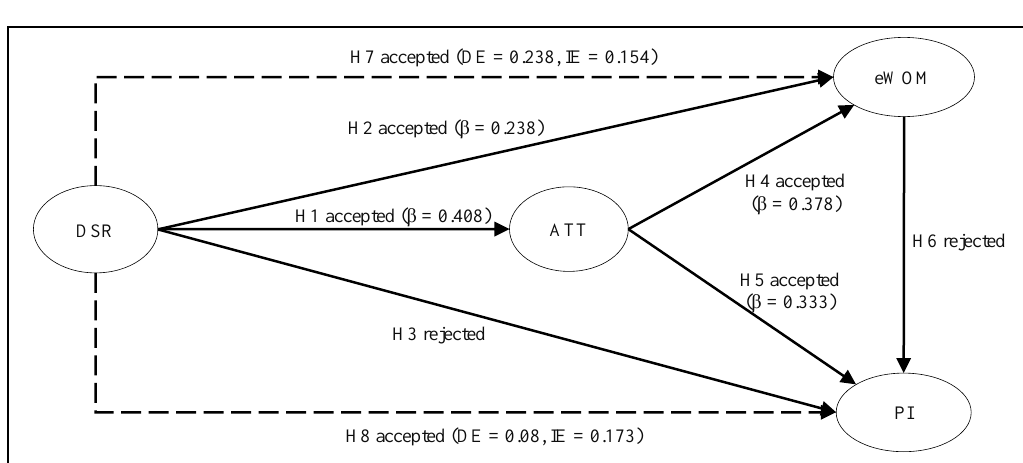
Figure 3. Summary of hypothesis